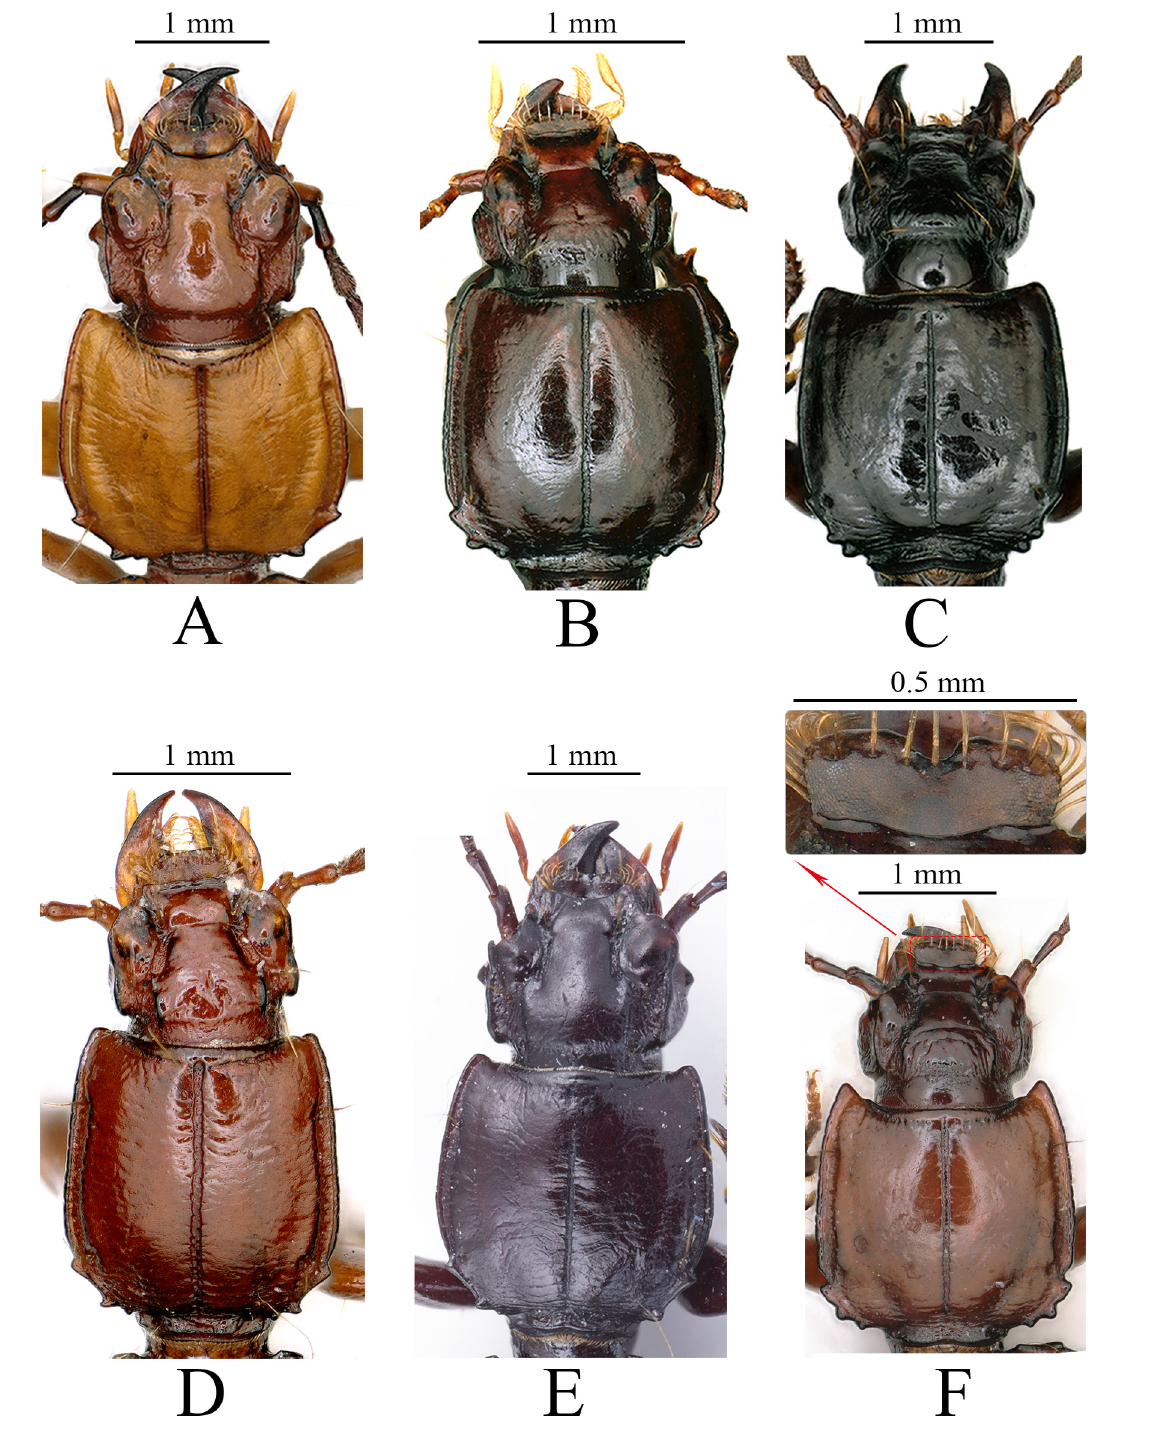
Fig. 3. Head and pronotum of species of Guiodytes Tian, 2013. A . G. deharvengi Tian, 2014. B . G. bedosae Tian, 2013. C . G. cavicola Tian, 2013. D . G. weii Huang & Faille sp. nov., holotype, ♂ (SCAU). E . G. yueliangensis Huang & Tian sp. nov., holotype, ♂ (SCAU). F . G. inexpectatus Tian & Zhou sp. nov., holotype, ♀